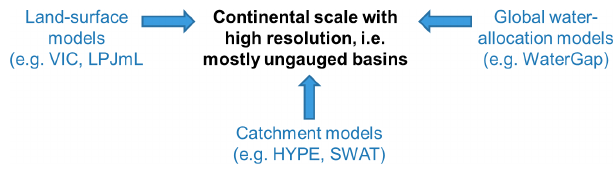
Figure 1. Different modelling communities who can now start com- paring their